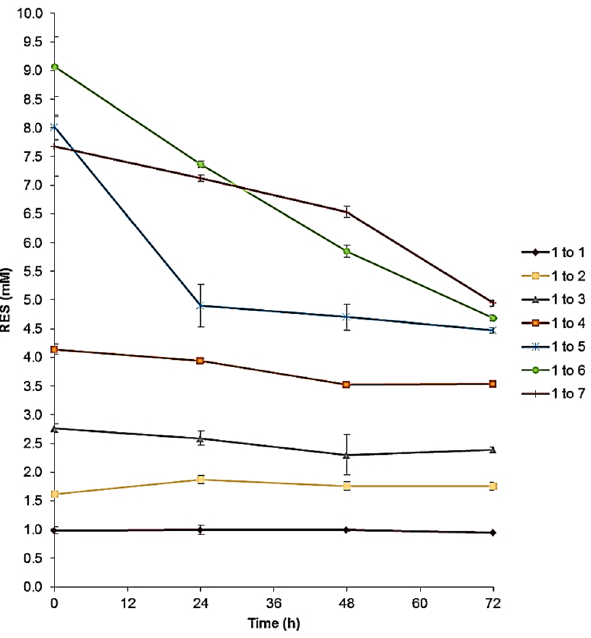
Figure 7. Stability over time of aqueous micellar dispersions maintained at 25 °C, obtained using RES:TPGS ratios of 1:1, 1:2, 1:3, 1:4, 1:5, 1:6, and 1:7 ( w / w ) in the preparative